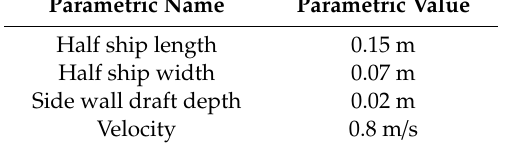
Table 1. Parameters of the Kelvin wake simulation target.